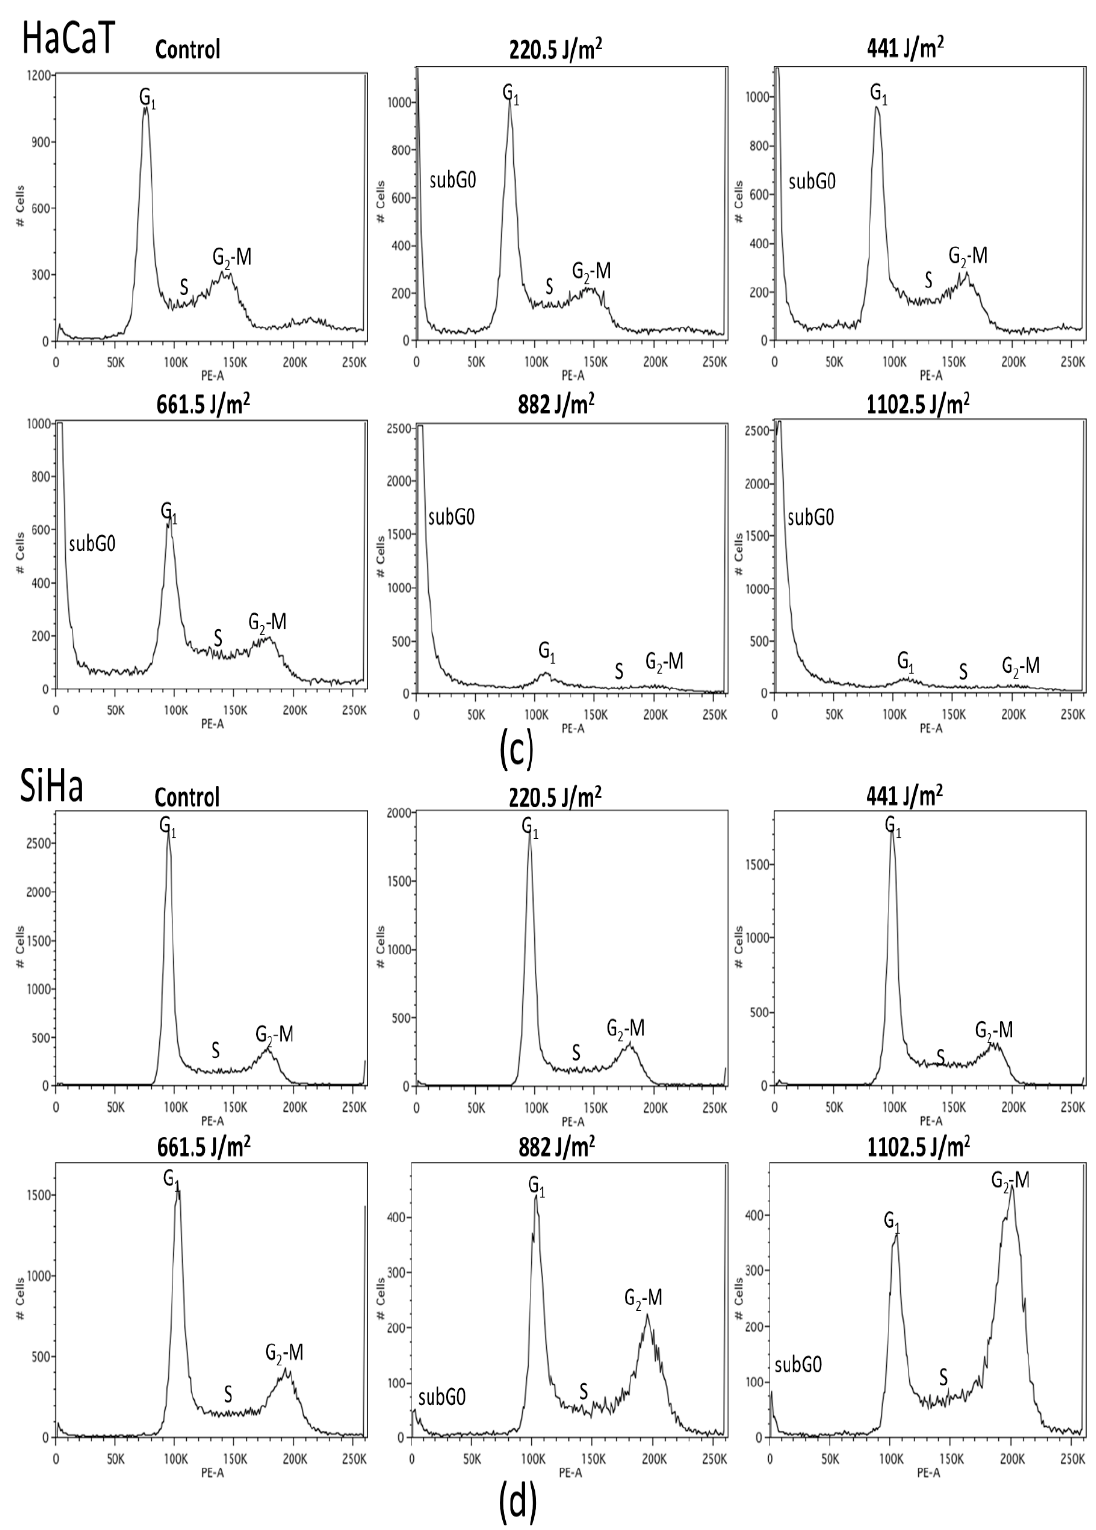
Figure 2. UVB inhibits cell cycle of cervical cancer cell lines in a dose-dependent manner. ( a ) C-33A, ( b ) CaLo, ( c ) HaCaT and ( d ) SiHa cells were treated with increasing doses of UVB and cell cycle was analyzed by flow cytometry after 72 h of incubation. Control cells were not UVB irradiated. Phases of cell cycle, G 1 , S and G 2 -M are shown in the figure. Sub-G0 phase is indicative of cell death.